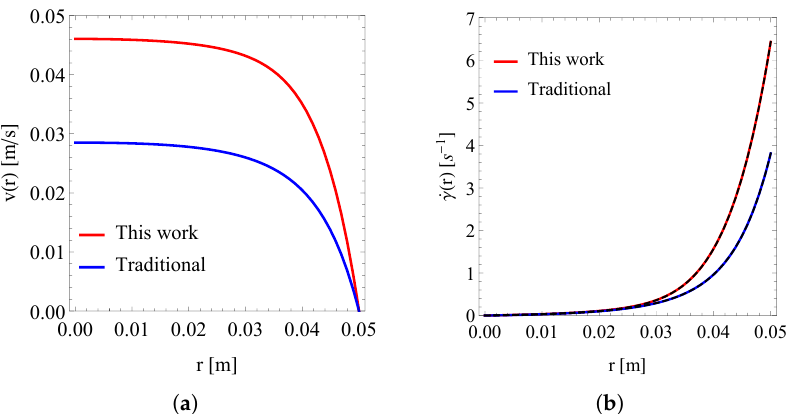
Figure 10. Velocity profile ( a ) and local shear rate ( b ) at pressure gradient = 7.5MPa/m. Tube radius R = 0.05rm.